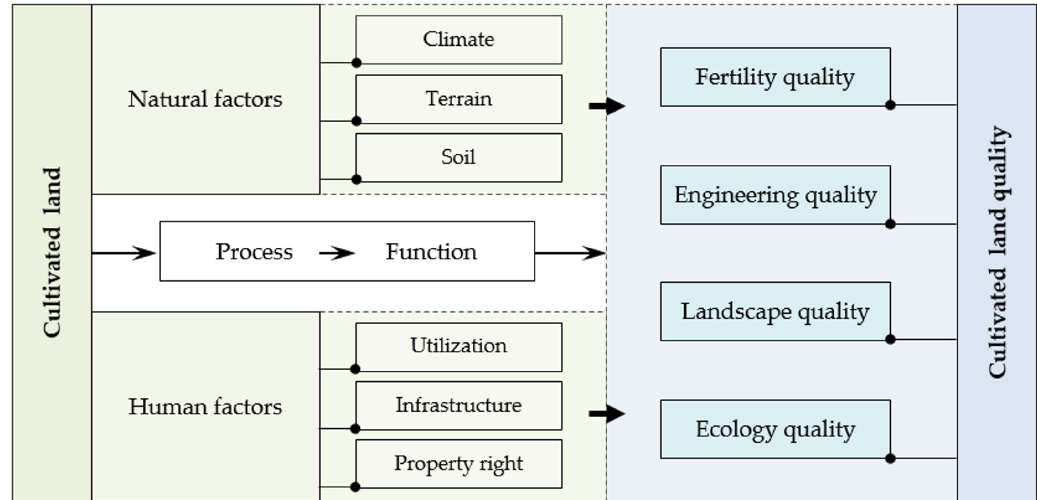
Figure 1. Theoretical framework for cultivated land quality.